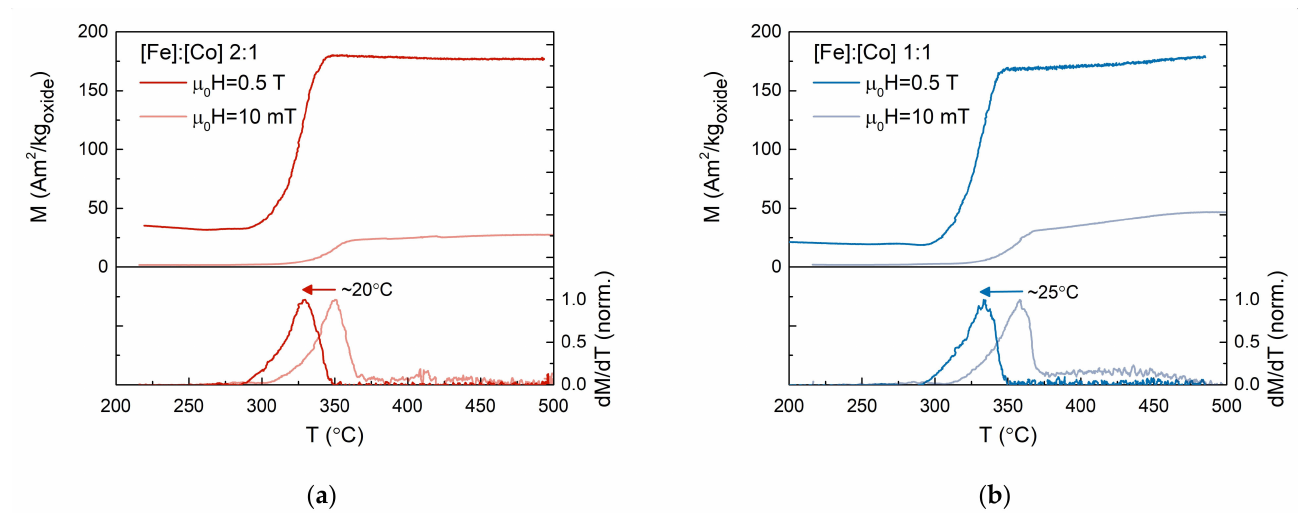
Figure 4. Temperature dependence of magnetization under an external magnetic field of 10 mT and 0.5 T, measured during the H 2 reduction of ( a ) CoFe 2 O 4 and ( b ) (CoFe) 3 O 4 MNPs. Bottom panels: normalized first derivative of magnetization vs. temperature